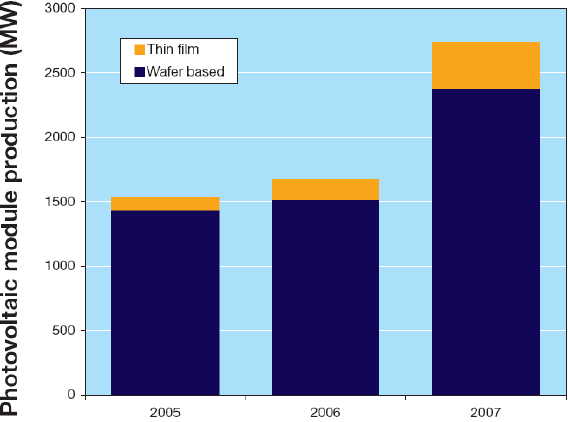
Figure 57. Thin film versus crystalline PV cell production. © 2008 OECD/IEA, reproduced from [54] with